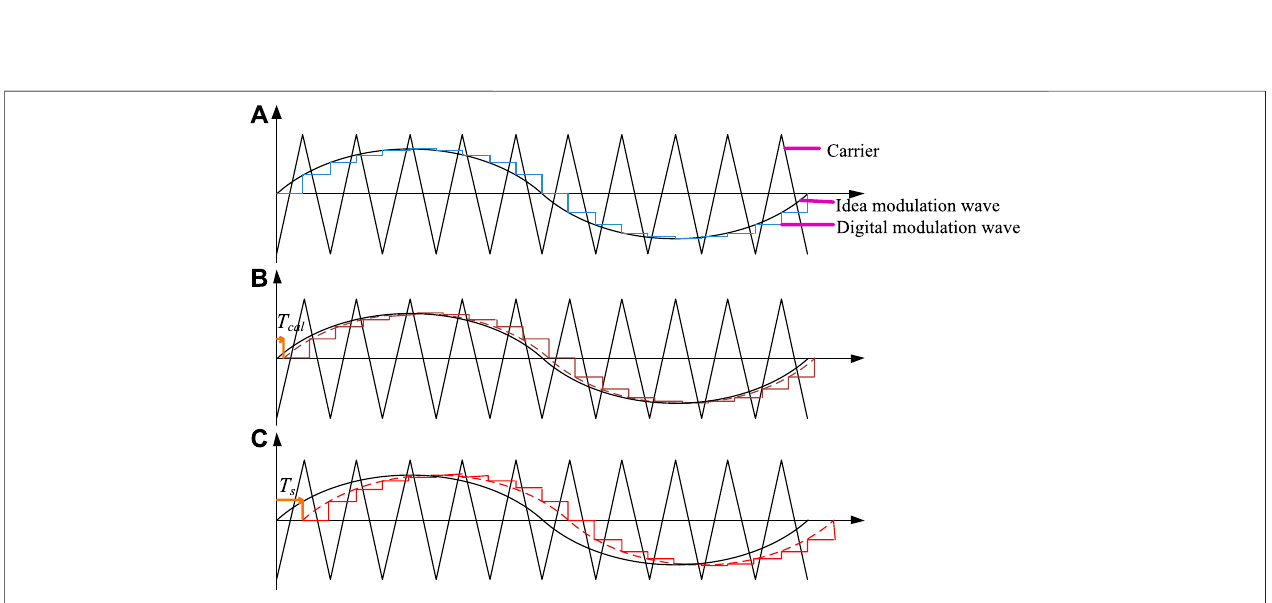
FIGURE 4 | The timing sequence of the DPWM process. (A) The ideal DPWM, (B) the DPWM with the immediately updated modulation wave, (C) the DPWM with one-step delay updated modulation wave.